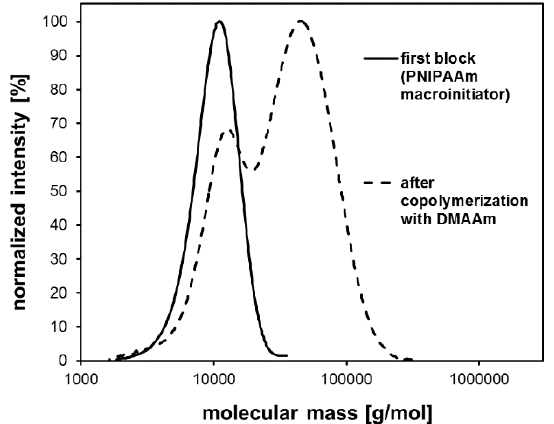
Figure 4. Molecular mass distribution of the PNIPAAm- b -PDMAAm copolymers obtained by sequential monomer addition as a result of SEC analysis.